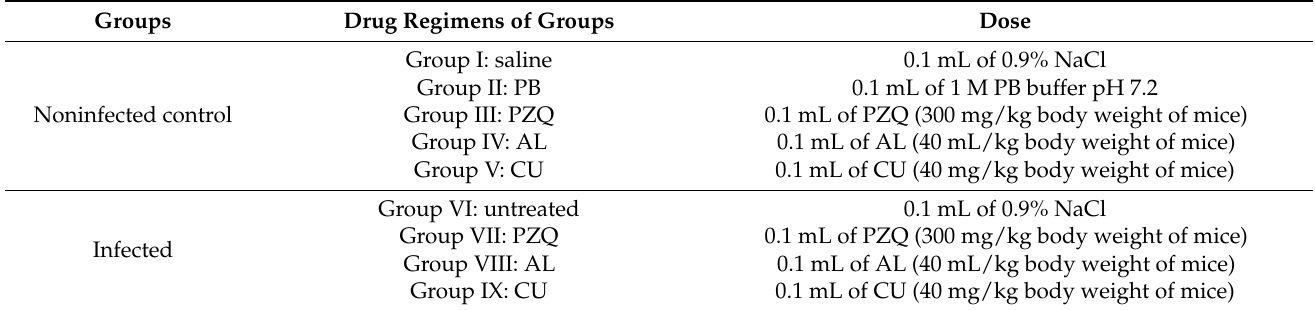
Table 7. Experimental